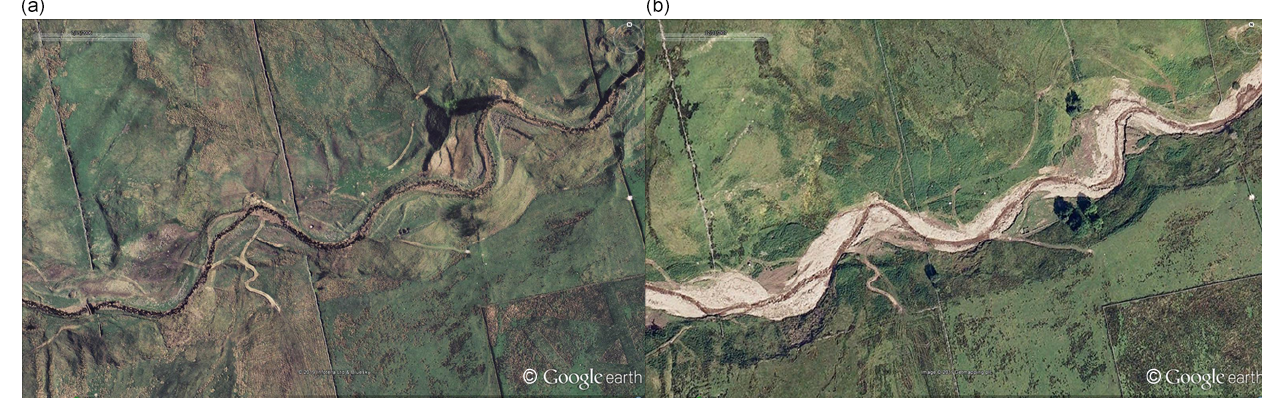
Figure 2. Google Earth images showing the reach section surveyed and used for Flash Flood!. Panel (b) is from before the flood in 2006 (Google Earth, 2019a) and (a) from after the flood in 2007 (Google Earth, 2019b). The flood has cut meanders resulting in a straighter channel, stripped-out vegetation, and deposited loose sediment on the flood plain (the lighter colour in b ).